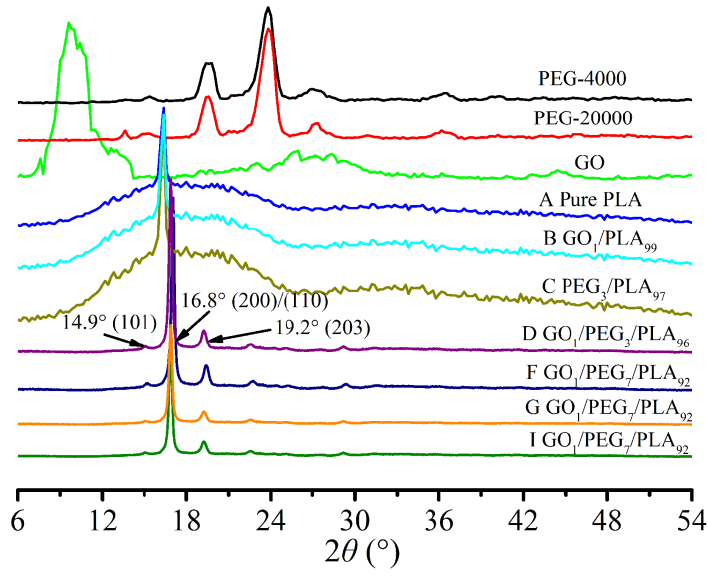
Figure 6. Wide angle X-ray diffraction (WAXD) diffraction patterns of PEG, pure PLA, GO/PLA, PEG/PLA, and GO/PEG/PLA multi-phase composites with different component ratio under different melt-compounding.